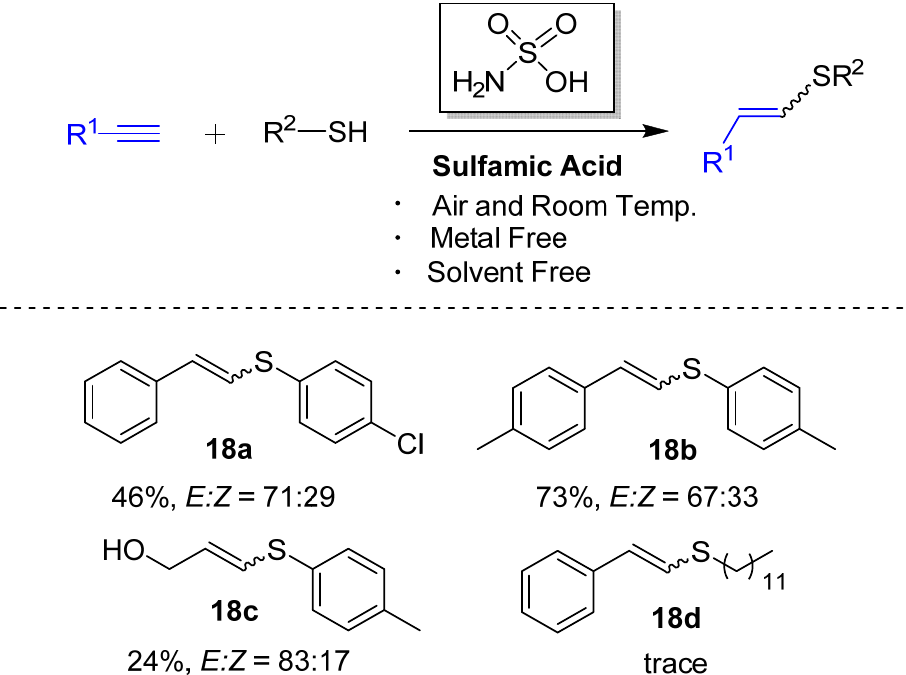
Scheme 18. Metal- and solvent-free synthesis of thioesters via regioselective alkyne